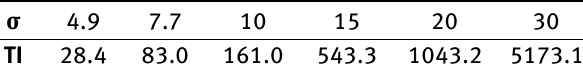
Figure 5: Sketch of the different metal plates used as perforated facing (horizontal and vertical Kundt